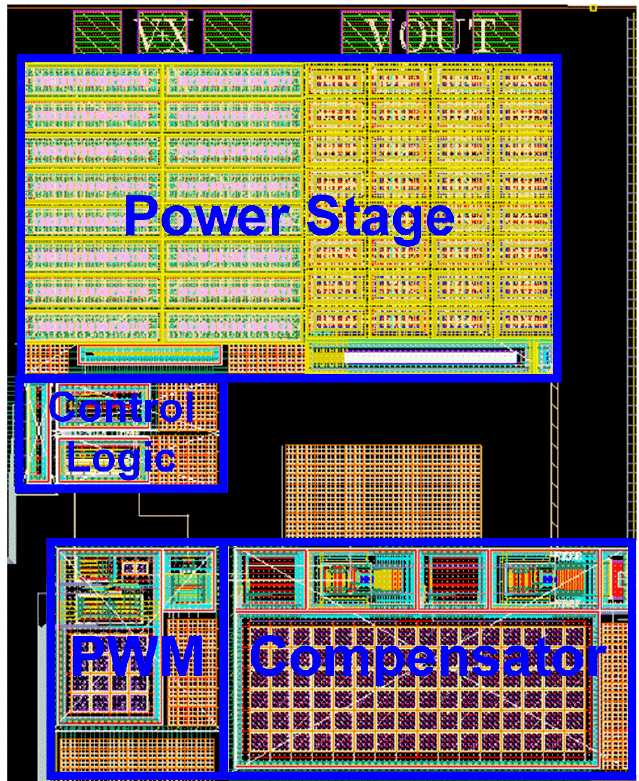
Figure 10. Full layout diagram of proposed boost converter.